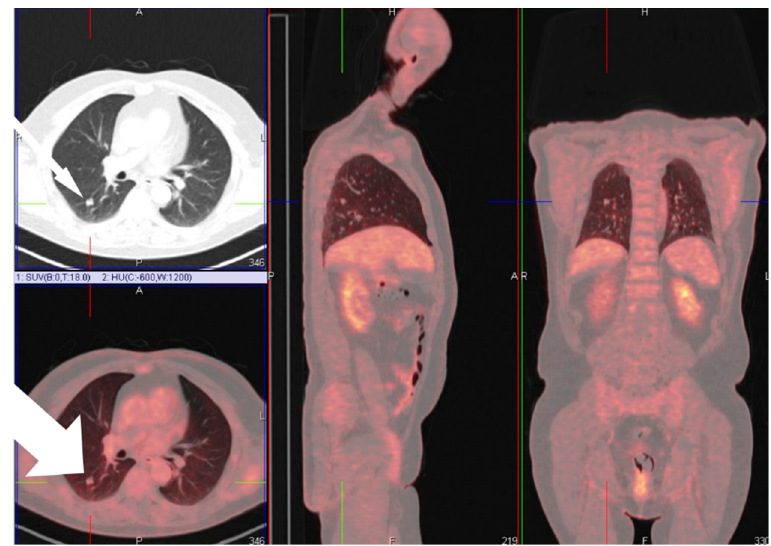
Figure 2. PET-CT showing moderate FDG-avidity of a lesion on PET scan in the right lower lobe with evidence of calcification or ossification on the diagnostic CT. FDG, fluorodeoxyglucose.